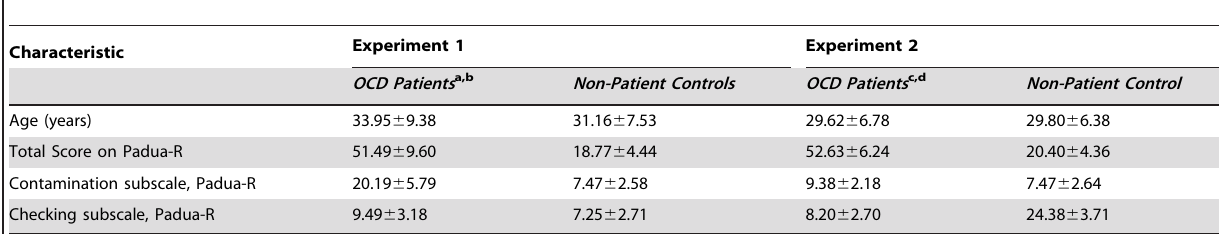
Table 1. Demographic and Clinical Characteristics of Participants in Experiments 1 and